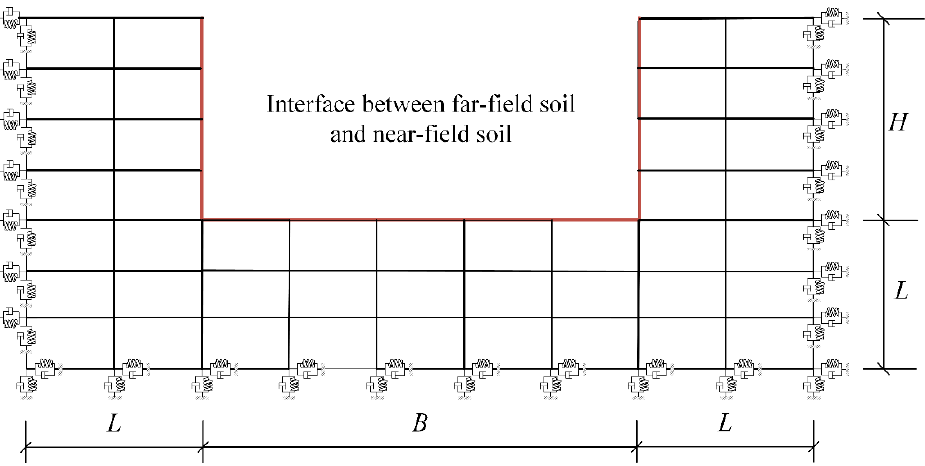
Figure 1. Finite element model D2 for simulation of the far-field zone, established by the T-DDSE